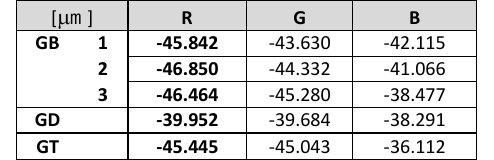
Table 8. Comparison of radial distortion correction in 1.9 mm radial distance. All units in  m.